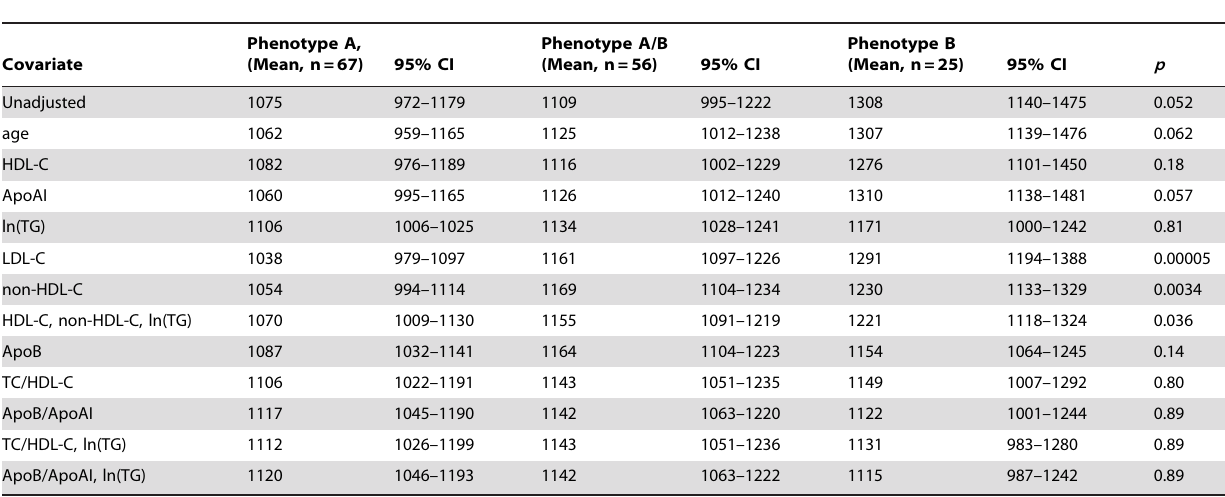
Table 2. LDL-P across LDL density phenotype adjusted for potentially confounding